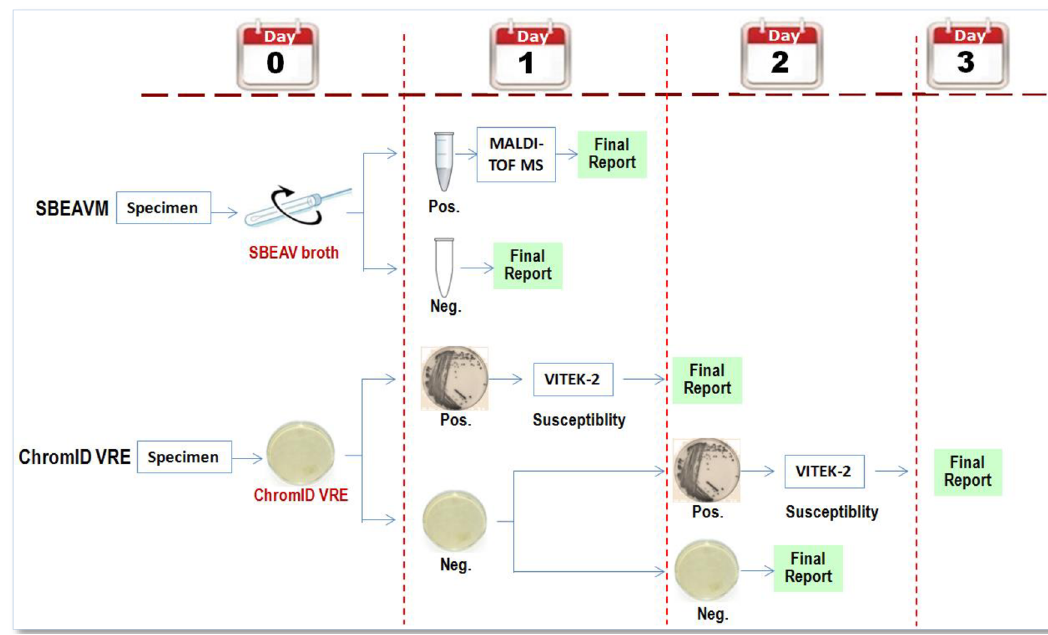
Fig 1. Flow diagram of the two methods used for vancomycin-resistant enterococci (VRE) screening in this study.